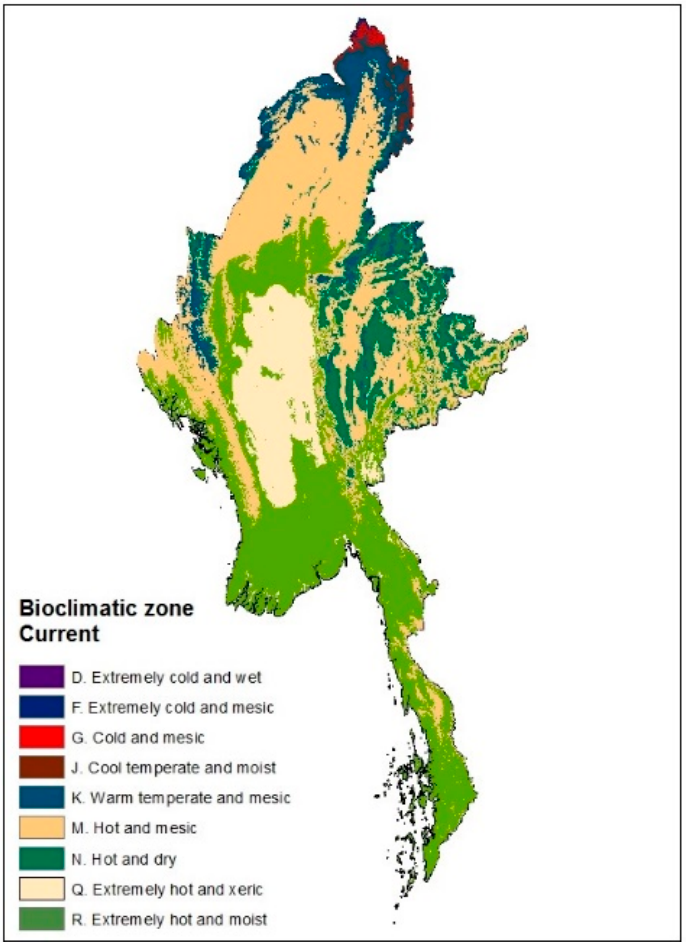
Figure 1. Distribution of the bioclimatic zones of Myanmar based on climate data from 1960–2000.